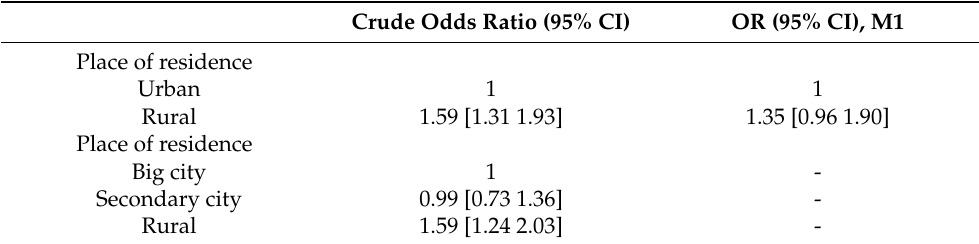
Table 3. Factors associated with anemia in the eight (8) regions in